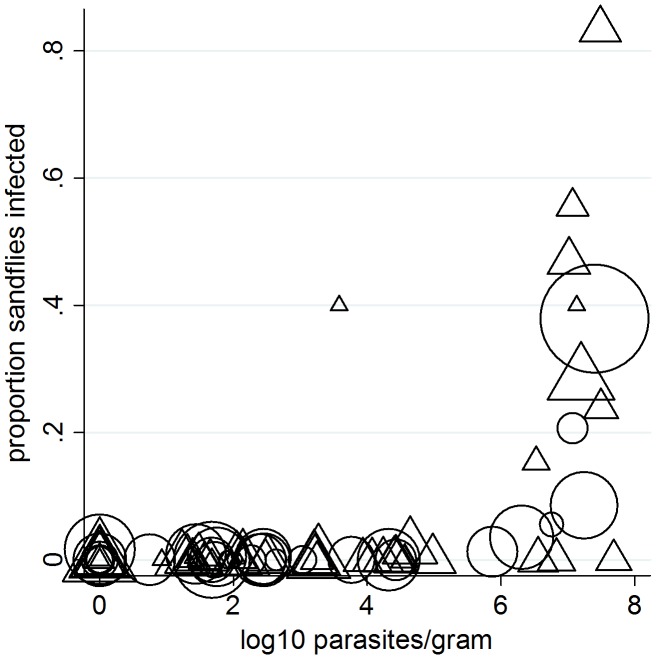
Relationship between L. infantum parasite loads in infected dog skin biopsies and infectiousness to sandflies.Individual dog infectiousness was measured as the proportion of exposed and blood-fed colony-reared Lu. longipalpis sandflies infected during xenodiagnosis. The figure shows results for individual samples (n = 58, triangles), and for the mean parasite load and proportion infected for each dog (n = 26, circles). Symbol size corresponds to sampling weight (number of fully engorged sandflies dissected).